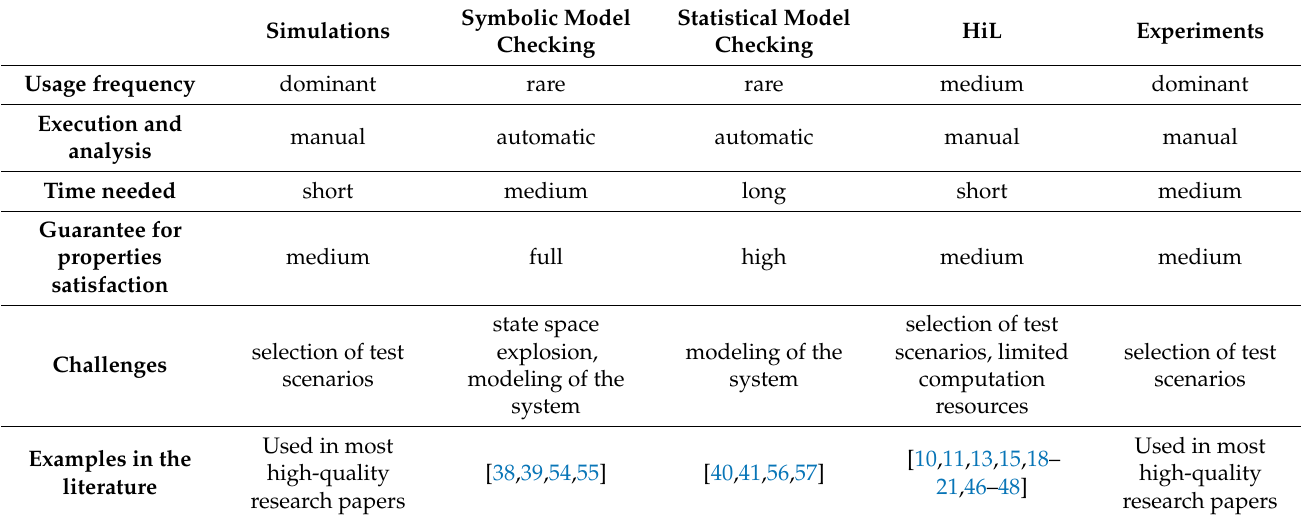
Table 3. Comparison of verification methods of control algorithm in power electronics systems.